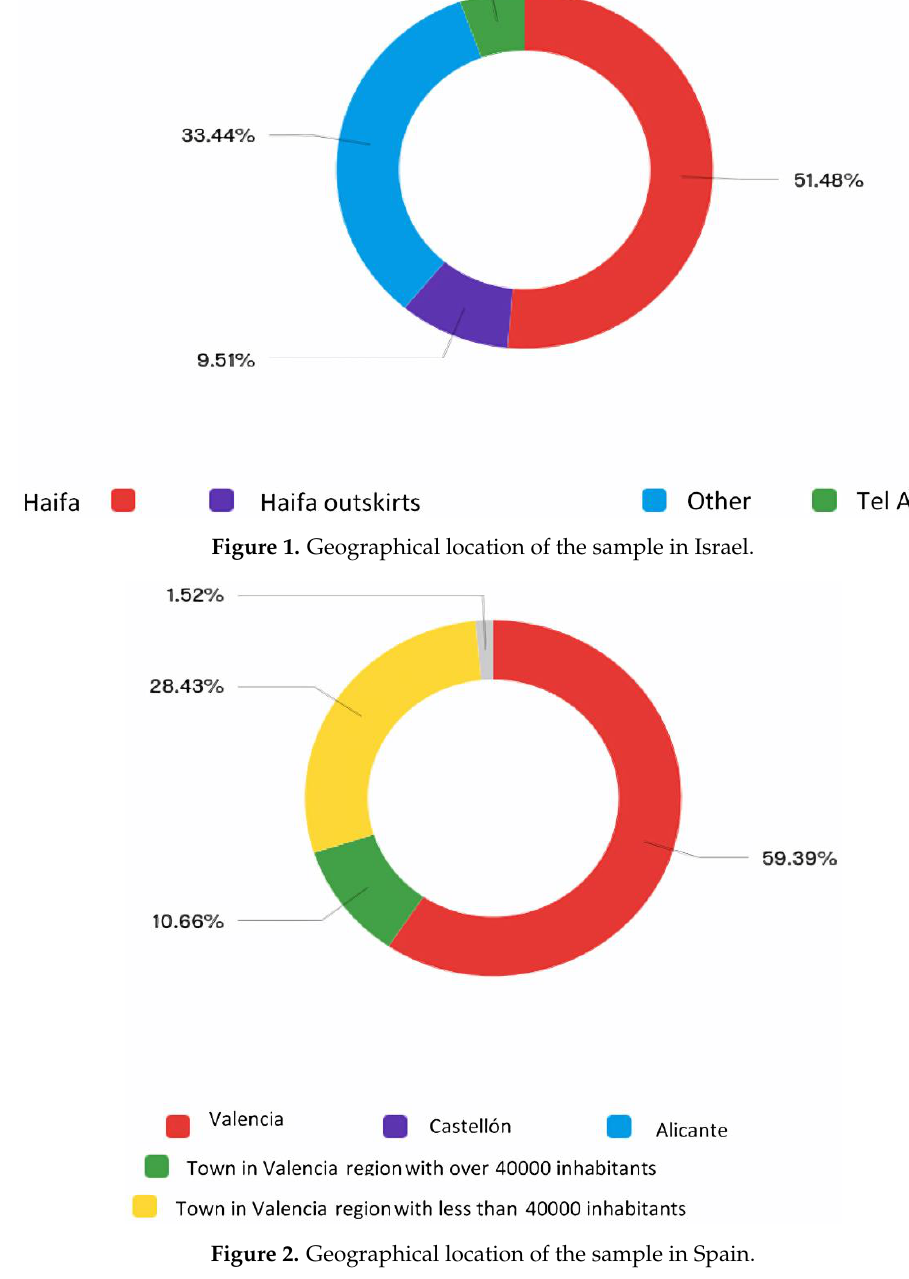
Figure 2. Geographical location of the sample in Spain.